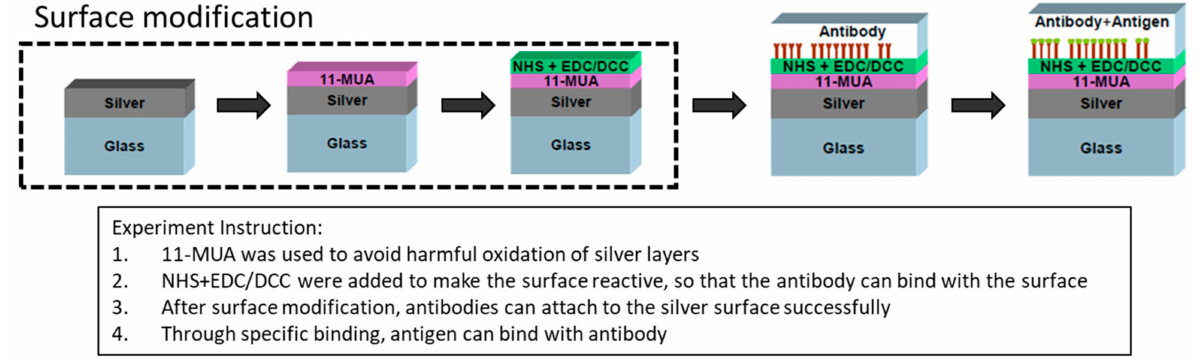
Figure 3. Flow chart of surface modification of silver